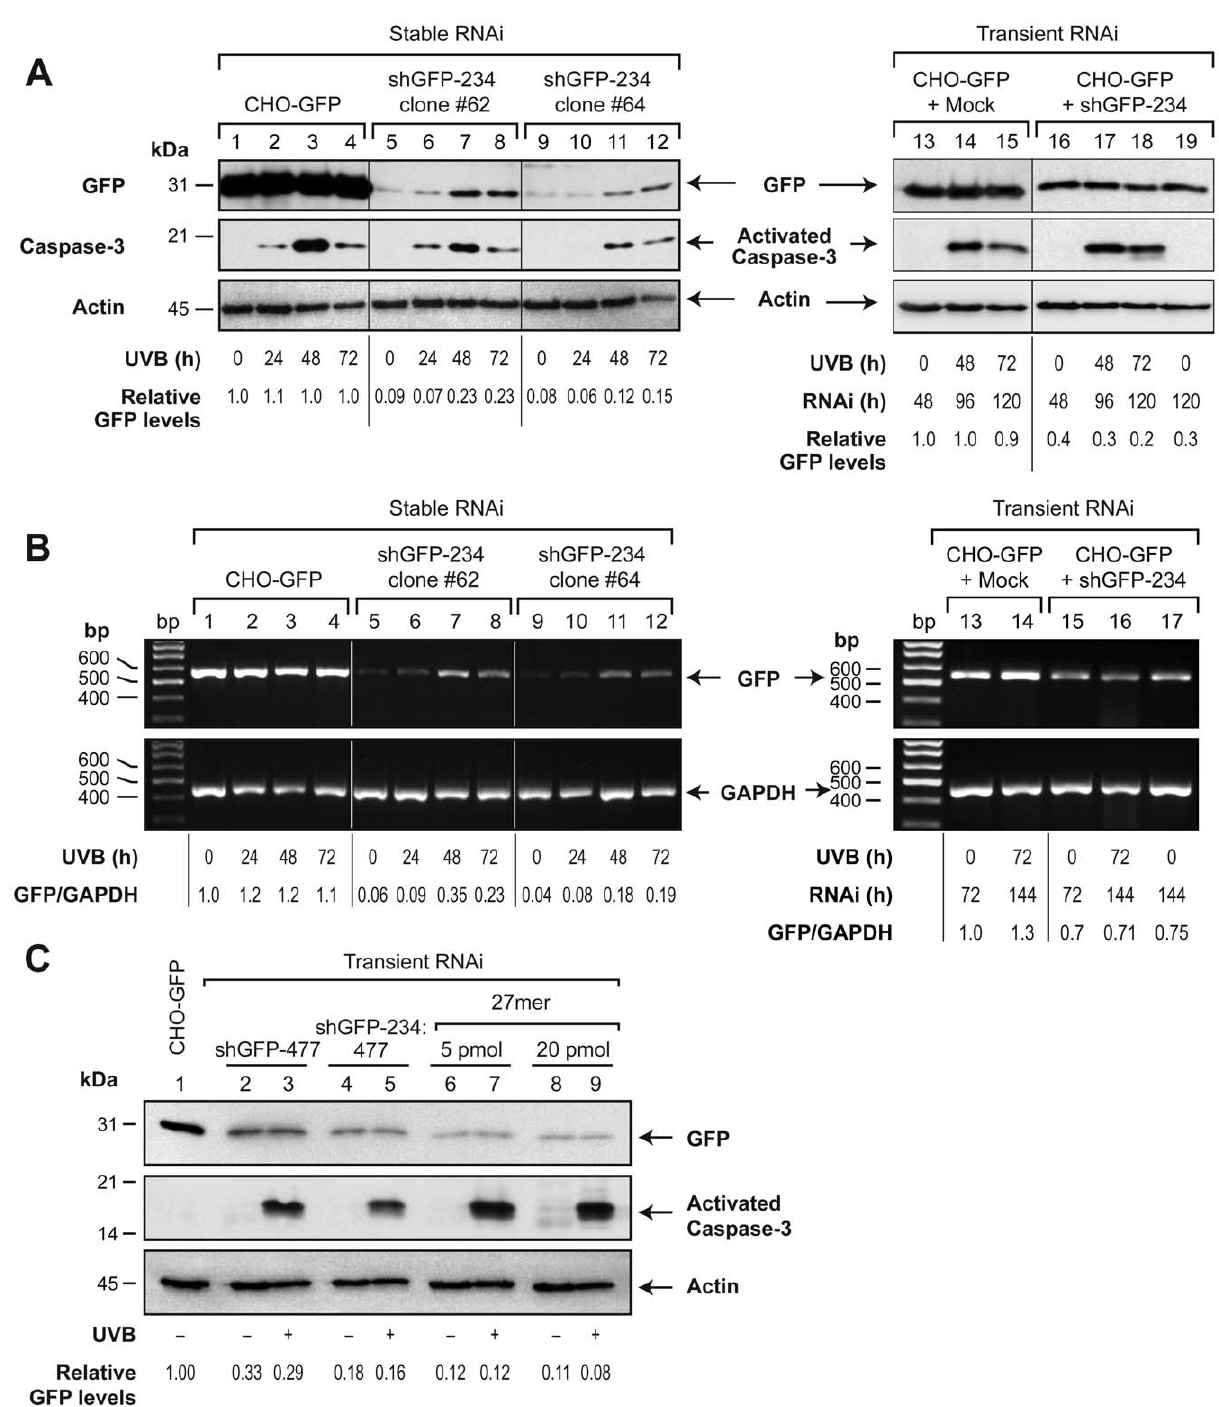
Figure 1. Failure of stable but not transient RNAi of stably expressed GFP during apoptosis in CHO-GFP cells. ( A ) Comparison of GFP protein knockdown levels during stable versus transient RNAi by shGFP-234. For stable RNAi (left panel), CHO-GFP parental cells and its two stable shGFP-234 clones # 62 and 64 were treated with 1,600 J/m 2 UVB and samples were harvested from 24–72 h for immunoblotting. For transient RNAi (right panel), CHO-GFP cells were transfected with shGFP-234 (or mock pCMV vector) for 48 h, treated with UVB and harvested from 48–72 h for immunoblotting. Caspase-3 probing served to confirm apoptosis and actin-probing served as a loading control. GFP-levels are expressed relative to the untreated CHO-GFP controls (lanes 1 and 13). ( B ) Comparison of GFP transcript levels during stable versus transient RNAi by shGFP-234. From the cells treated as above, total RNA was extracted and subjected to RT-PCR determination of mRNA for GFP and GAPDH, the ratio of GFP/GAPDH is expressed as relative to respective untreated control (lanes 1 and 13). For both A and B panels, experiments were repeated 3–4 times with identical results. ( C ) Comparison of GFP protein knockdown levels in cells with variable extent of transient RNAi introduced by shGFP-234, shGFP-477 or 27mer dsRNA. The CHO-GFP cells were transfected with 3 m g shGFP-477 alone or in (1:2) combination with shGFP-234, and with different concentrations of 27mer dsRNA. The control CHO-GFP cells were mock transfected with unrelated shRNA-generating DNA vector. At 72 h after transfection,